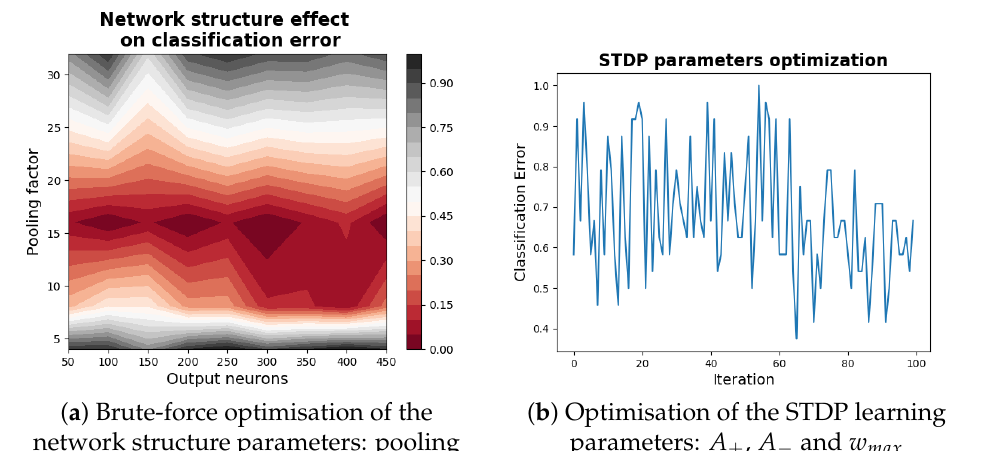
Figure 6. Optimisation of the SNN. ( a ) Distribution of classification performance based on pooling factor (pf) (which determines the size of the hidden layer) and the number of output neurons ( n output ) . ( b ) Change in classification performance over iterations during the Bayesian optimisation of the STDP learning parameters: A + , A − and w max .